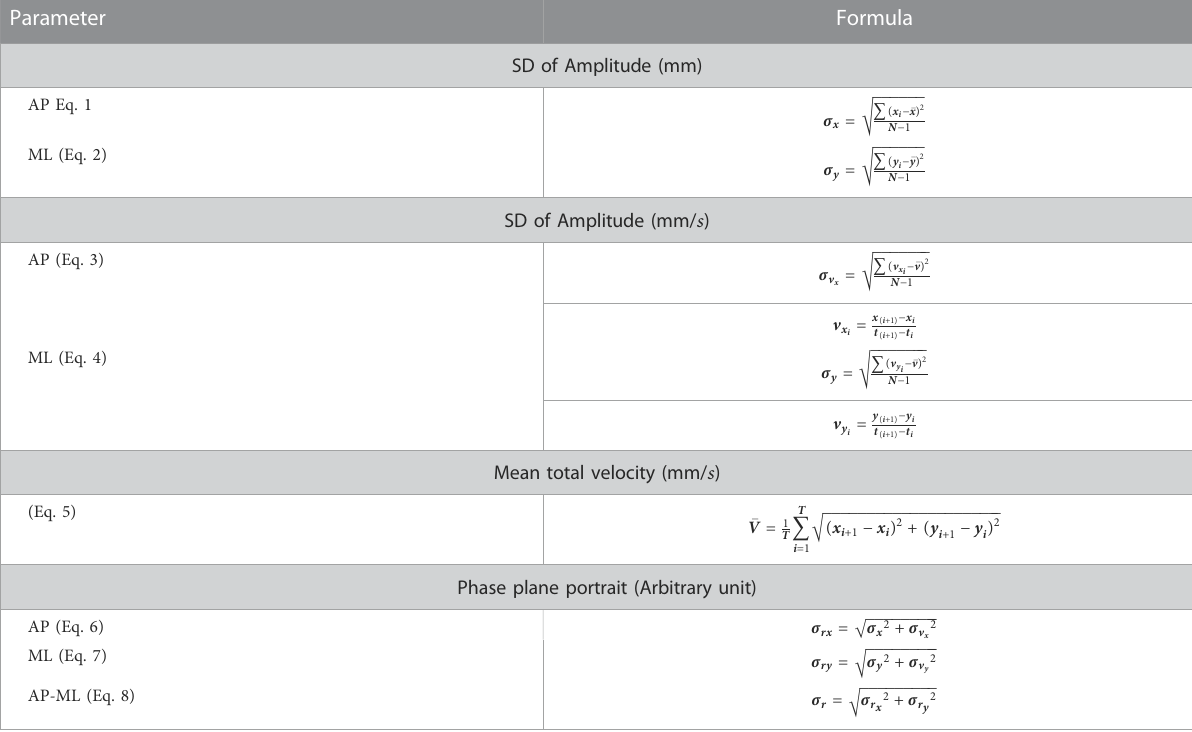
TABLE 2 Linear parameters of COP analysis (Salavati et al., 2009).